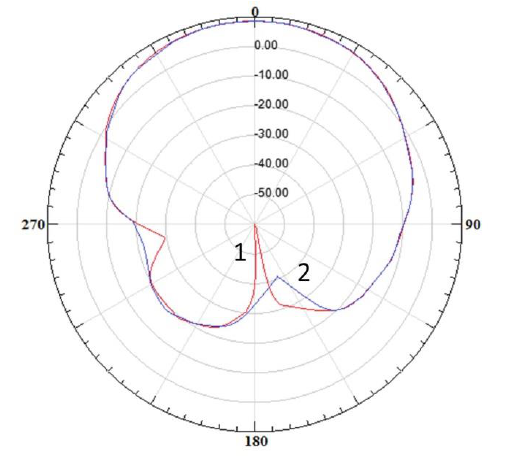
Fig. 4. Radiation patterns in E-plane (1 - mesh patch, 2 - solid patch).